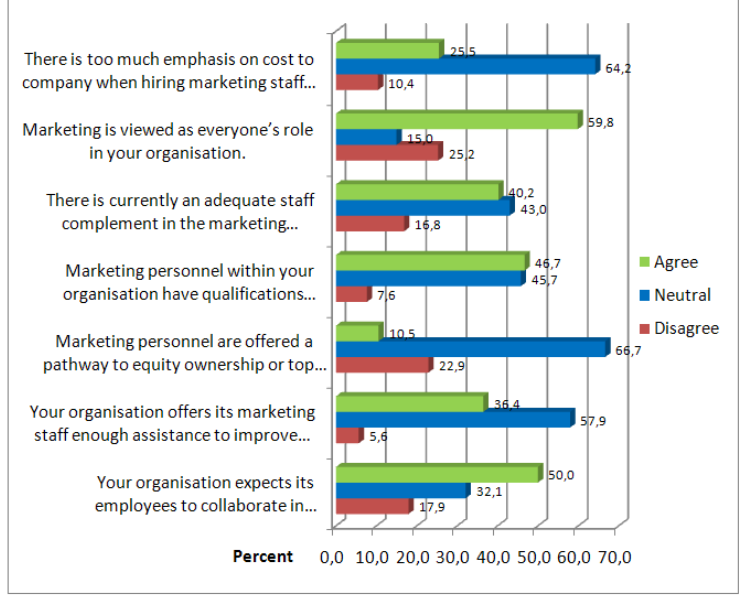
Fig. 8. Respondent scores: